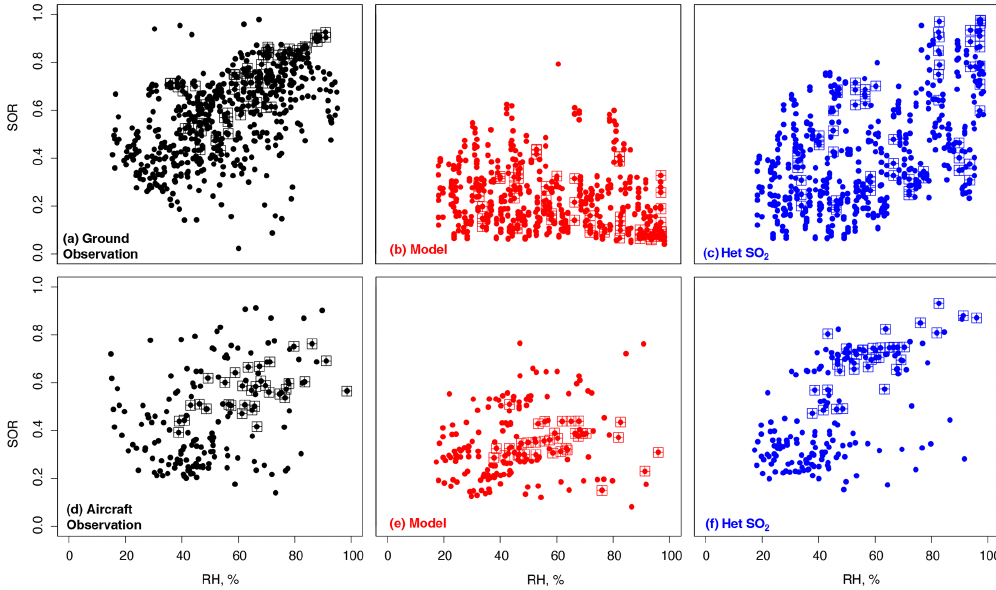
42 − ) as a function of RH at Olympic Park and from aircraft below 1km for the descents Figure 12. Sulfate oxidation ratio (SOR = SO SO 42 − + SO 2 over Olympic Park. The squares highlight the data during the Transport/Haze period.